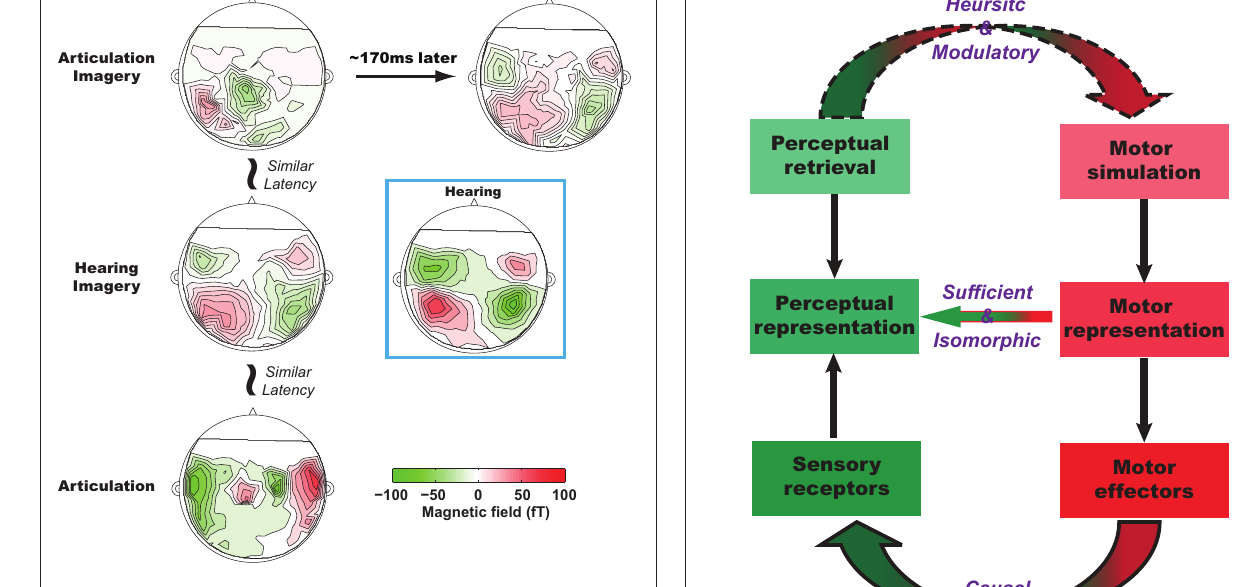
FIGURE 2 | Results from Tian and Poeppel (2010). The sequential estimation during articulation imagery revealed by MEG recordings. All plots are MEG topographies (response patterns) when participants actually speak (lower row), imagine hearing (middle row), and imagine speaking (top row). The activity patterns in the first column are temporally aligned with the onset of articulation movement. At a similar latency, bilateral frontal, bilateral temporal, and left lateralized parietal activity patterns are observed in articulation, hearing imagery, and articulation imagery conditions. In articulation imagery, about 150–170ms later after the parietal activity, bilateral temporal activity is also observed. All the bilateral temporal activity patterns in hearing imagery and articulation imagery resemble the topography of the auditory response during actual hearing (highlighted in a blue box, response pattern when participants listen to the same auditory stimuli as in other conditions).